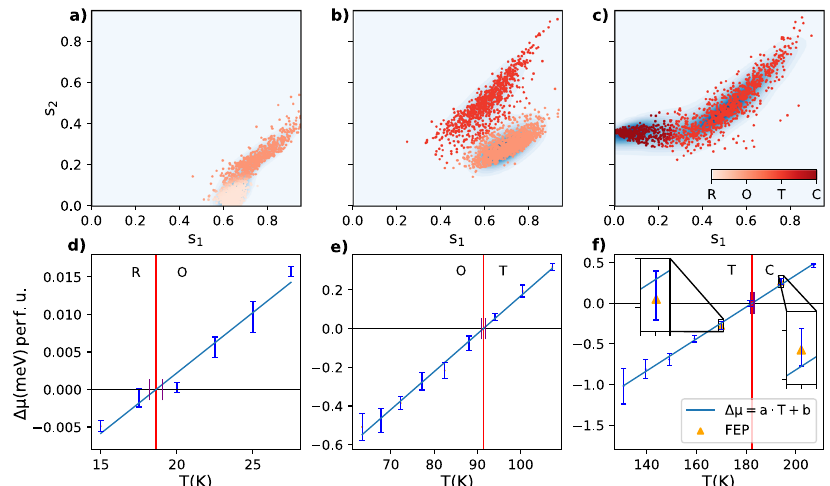
Fig. 6 Phase diagram of BaTiO 3 at ambient pressure. Panels a – c show the R-O, O-T, and T-C clusters in the ( s 1 , s 2 ) plane across the coexistence regions. Each con fi guration generated in the MD is a point in this plane, colored according to its probability P . The latter is computed via the probabilistic analysis of molecular motifs (PAMM) 139 algorithm (see Methods, subsection “ Physically-inspired order parameters ” for additional details). P is smoothly increasing in the [0, 1] interval while going from R to O (panel a ), then from O to T (panel b ), and fi nally from T to C (panel c ). Panels d – f show the temperature-dependent chemical potential differences across the R-O ( d ), O-T ( e ), and T-C ( f ) transitions. Blue error bars represent standard deviations computed across multiple MD runs, the cyan line the best linear fi t across the coexistence regions, and the purple error bars the propagated errors on the critical temperatures. In addition, the orange triangles in panel f show the free-energy perturbed chemical potentials, using 50 reference tetragonal and cubic structures just below (170 K) and above (194 K) the Curie point. 6× magni fi ed insets corresponding to these two temperatures show how the FEP-corrected chemical potentials consistently fall within the error bars due to the MD sampling, con fi rming the DFT accuracy of the GAP (see subsection “ Thermodynamics of BaTiO 3 ”